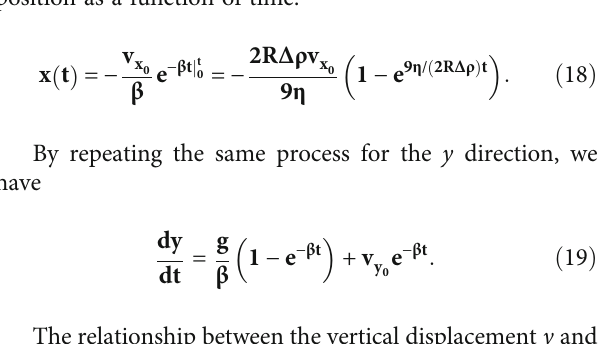
1 : 76m stands for the average height of people